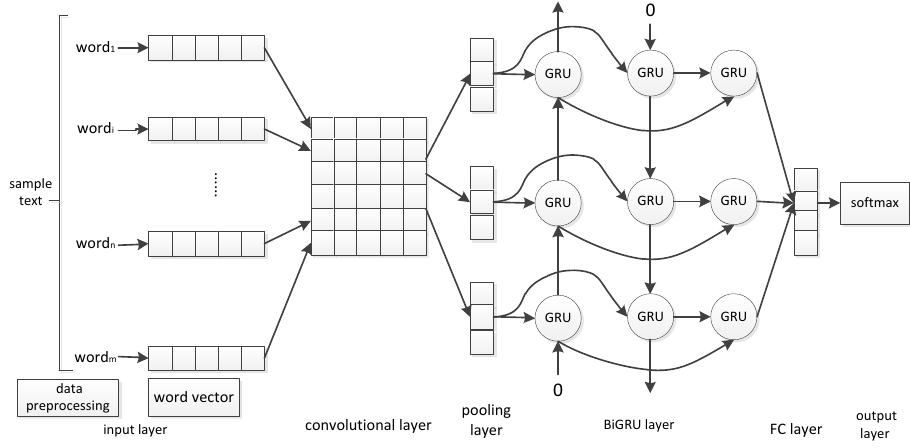
Figure 2. CNN + BiGRU Network Structure.